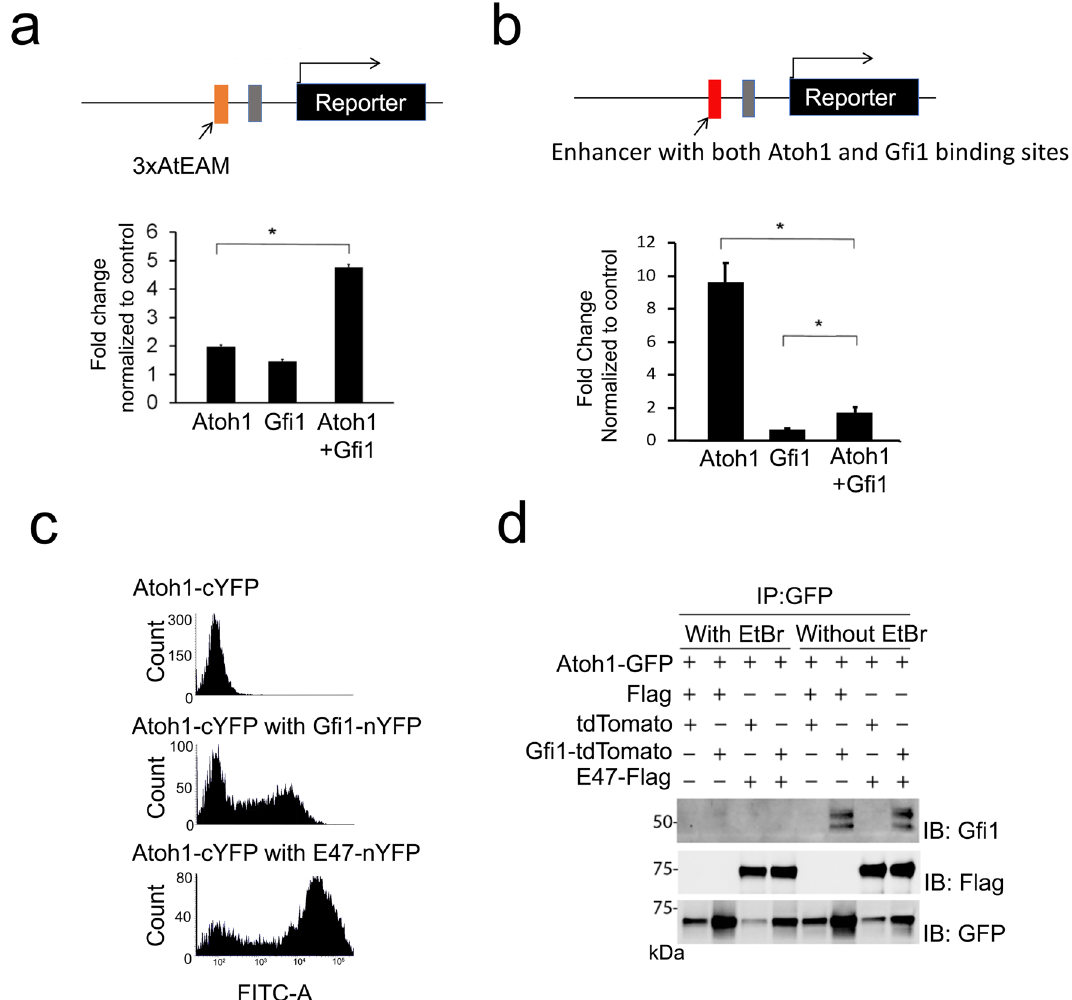
Figure 6. GFI1 enhances the transcription activity of ATOH1 in vitro in an off-DNA mechanism. ( a ) Luciferase assay using a reporter plasmid pNl3.1-3xAtEAM containing an artificial enhancer with 3xAtEAM domains (orange box) in front of a minimal promoter (gray box). The addition of GFI1 significantly enhances the transcriptional activation of the reporter construct by ATOH1, despite the fact that the enhancer contains no Gfi1 binding sites. Statistical significance was assessed by a Student t-test, comparing the average fold change after normalized to the control group each time. (*p < 0.01). ( b ) Luciferase assay using a reporter plasmid pNl3.1-AGmotifs containing an artificial enhancer with both ATOH1 and Gfi1 binding motifs (red box) in front of a minimal promoter (gray box). In this case, addition of GFI1 significantly attenuates the transcriptional activity of ATOH1. Statistical significance was assessed by a Student t-test, comparing the average fold change after normalized to the control group each time. (*p < 0.01). ( c ) Bimolecular fluorescence complementation assay of DAOY cells transfected with Atoh1-cYFP (top), Atoh1-cYFP and GFI1-nYFP (middle) and Atoh1- cYFP and E47-nYFP (bottom). Atoh1-cYFP protein can bind to E47-nYFP, giving a significantly enhanced fluorescence. However, the interaction between Atoh1-cYFP and GFI1-nYFP is significantly weaker. ( d ) Co-immunoprecipitation of ATOH1, GFI1 and E47 in 293 T cells. pCDNA3.1-Atoh1-GFP was transfected into 293 T cells with pEF-Gfi1-tdTomato or pCDNA3.1-E47-Flag. The ATOH1-GFP fusion protein was immunoprecipitated with GFP antibodies, and the blot probed with antibodies to GFI1, FLAG or GFP. GFI1 could be immunoprecipitated with ATOH1 in the presence of non-specific DNA binding (in the absence of ethidium bromide), but this interaction could be abolished by performing the experiment in the presence of ethidium bromide. In contrast, the interaction between ATOH1 and E47 was stronger, more specific and could still be observed in the absence of DNA